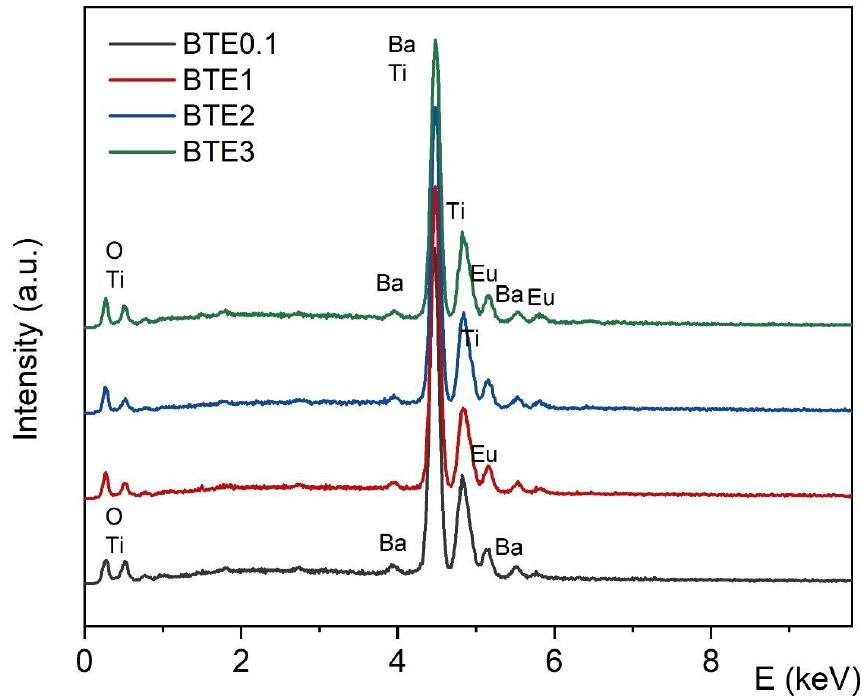
Figure 3. The Energy Dispersive Spectrometry (EDS) analysis of chemical elements of the BTEx ceramic samples: BTE0.1, BTE1, BTE2, and BTE3.